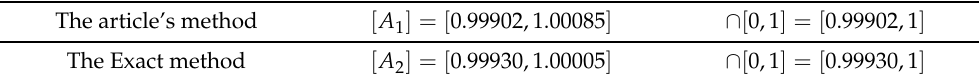
Table 1. The imprecise availability obtained by the two